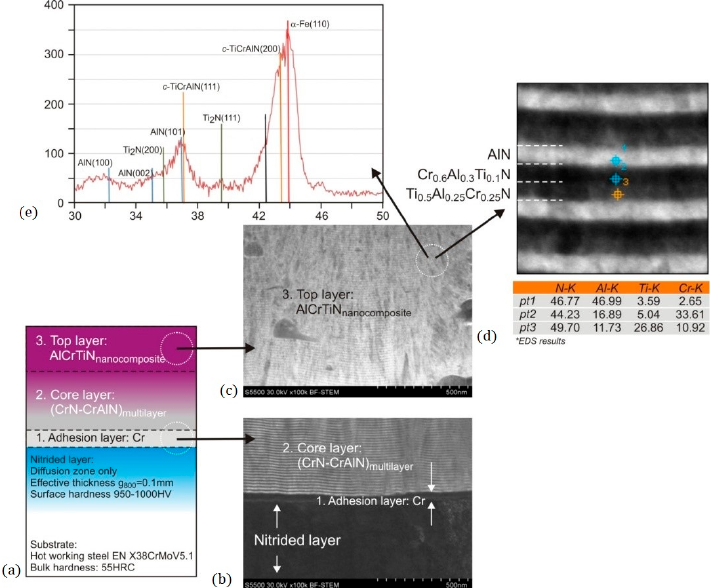
Figure 9. Hybrid layer NL + Cr/(CrN-CrAlN) multilayer /AlCrTiN nanocomposite : ( a ) scheme of the hybrid layer, ( b , c ) microstructure of the PVD coating, ( d , e ) results of the chemical composition test and phase structure test of the AlCrTiN nanocomposite top layer.